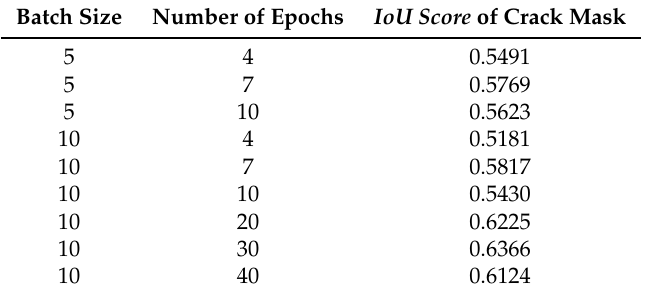
Table 1. Hyper-parameters of U-Net: Batch Size and Number of epochs are selected according to their respective Intersection-Over-Union (IoU) score .